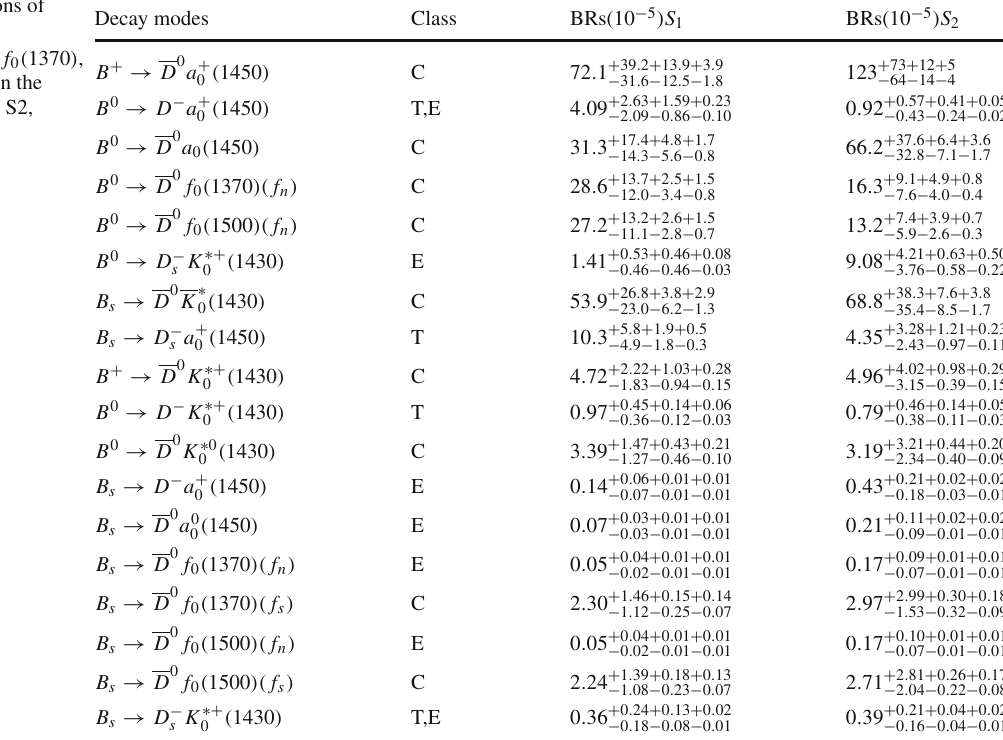
∗ S ( a 0 ,κ,σ, f 0 ) decays cal-